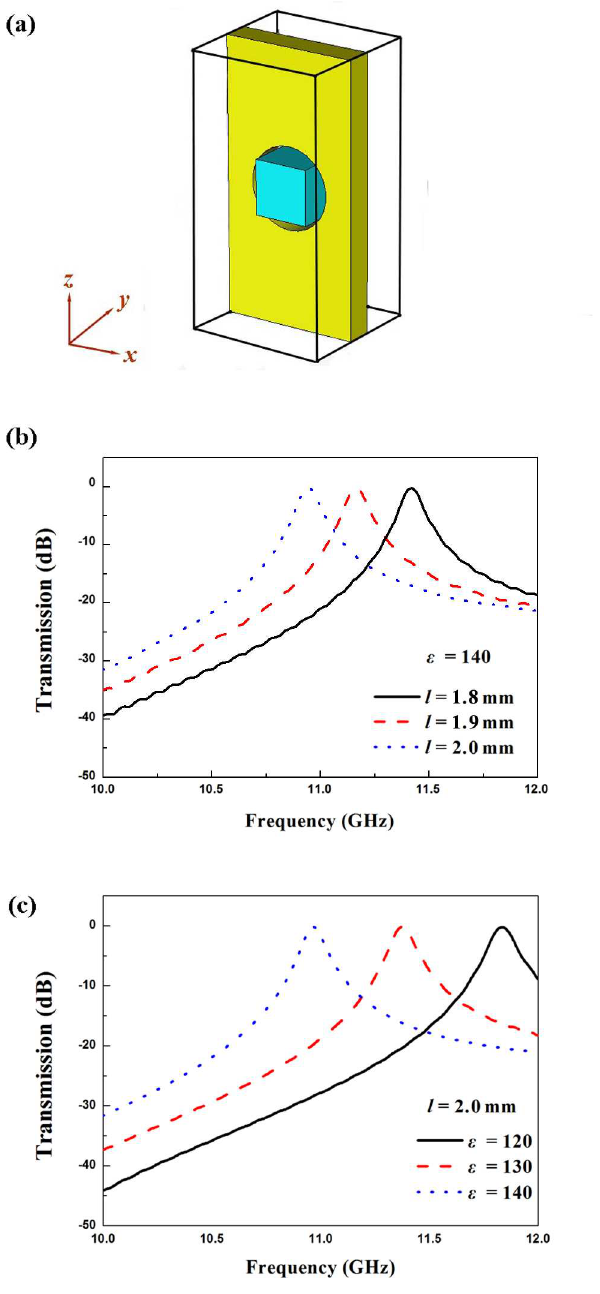
(C) Simulated transmission spectra with a series of permittivity ε